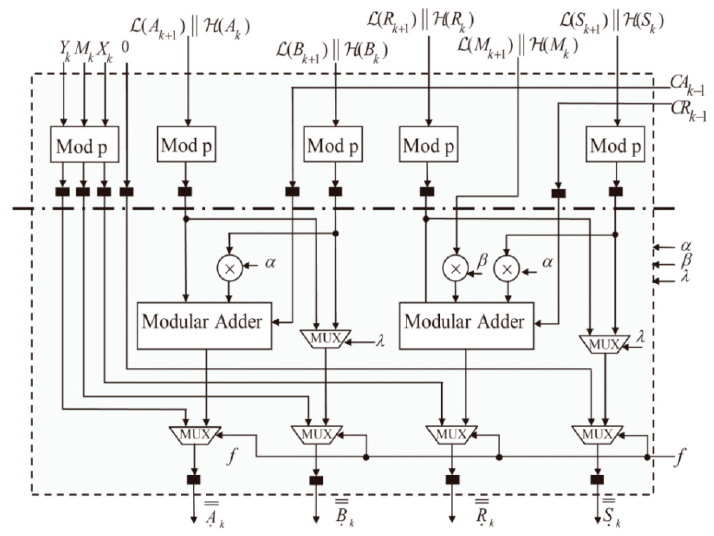
Figure 5. The logic diagram of CPP k.